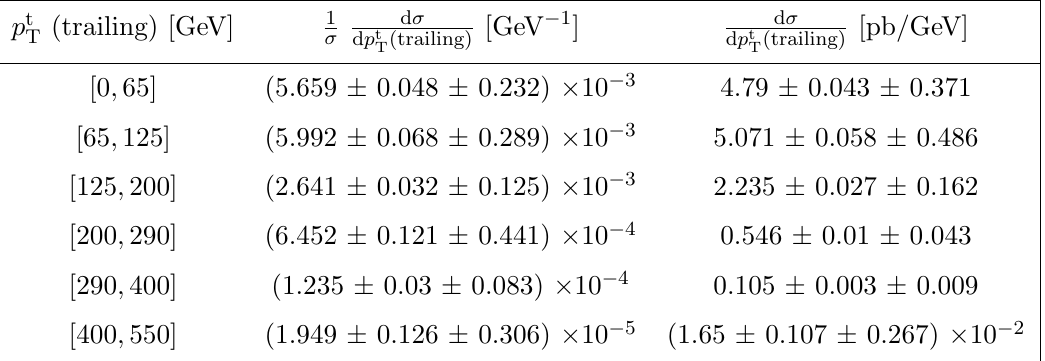
Table 4 . The measured di(cid:11)erential cross section and bin boundaries for each bin of the normalized and absolute measurements of the tt di(cid:11)erential cross section at parton level in the full phase space as a function of p t (trailing) are tabulated. T